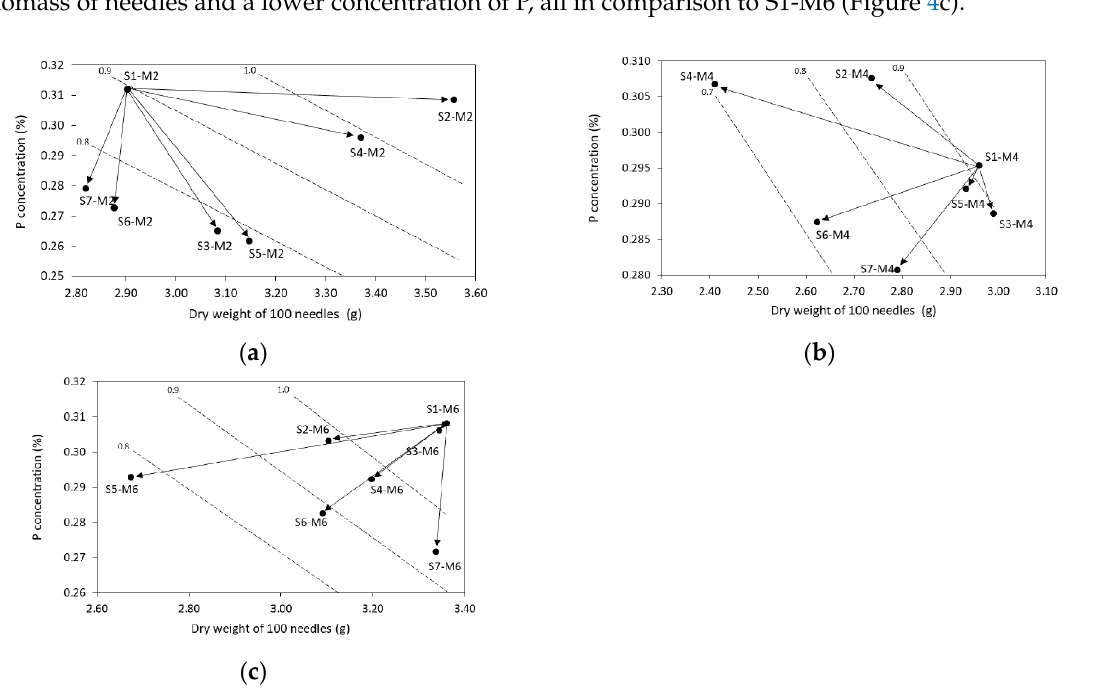
Figure 4. Vector nomograms of the concentration of phosphorus (P) in the foliage of Pinus engelmannii , produced in seven substrates with the addition of three doses of fertilization: ( a ) 2 g L − 1 Multicote ® , ( b ) 4 g L − 1 Multicote ® and ( c ) 6 g L − 1 Multicote ®